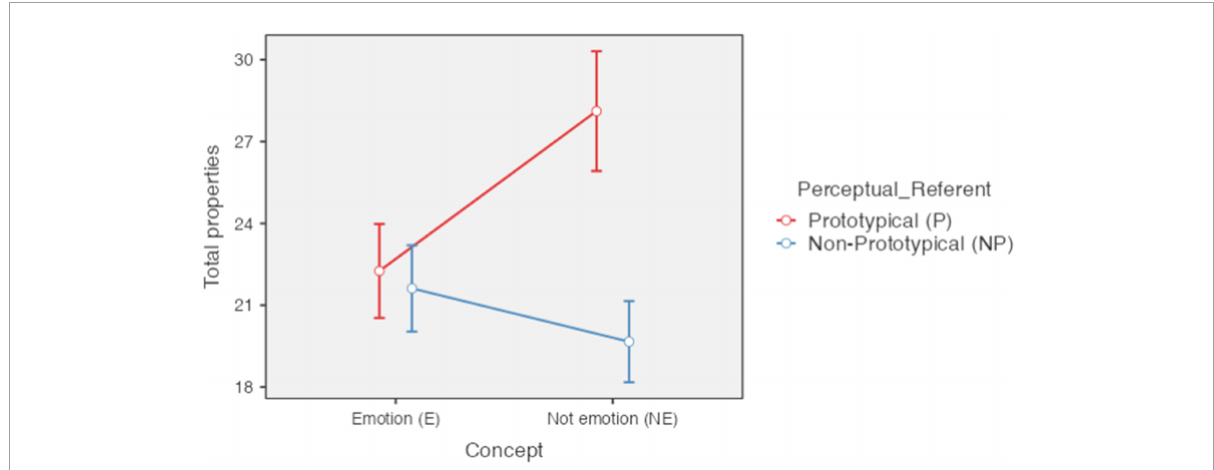
FIGURE4 Number of properties by type of concept and clarity of the perceptual referent. Error bars 95% CI; significant differences between concepts of, basic emotion and concrete (E-P_NE-P); basic emotion and abstract (E-P_NE-NP); secondary emotion and concrete (E-NP_NE-P);secondary